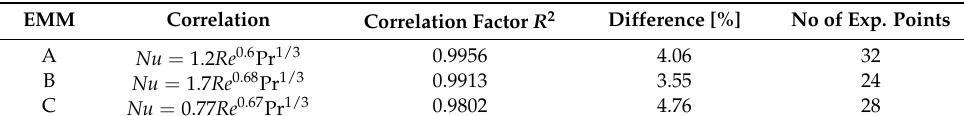
Table 4. Correlations for Nusselt numbers of expanded metal meshes.